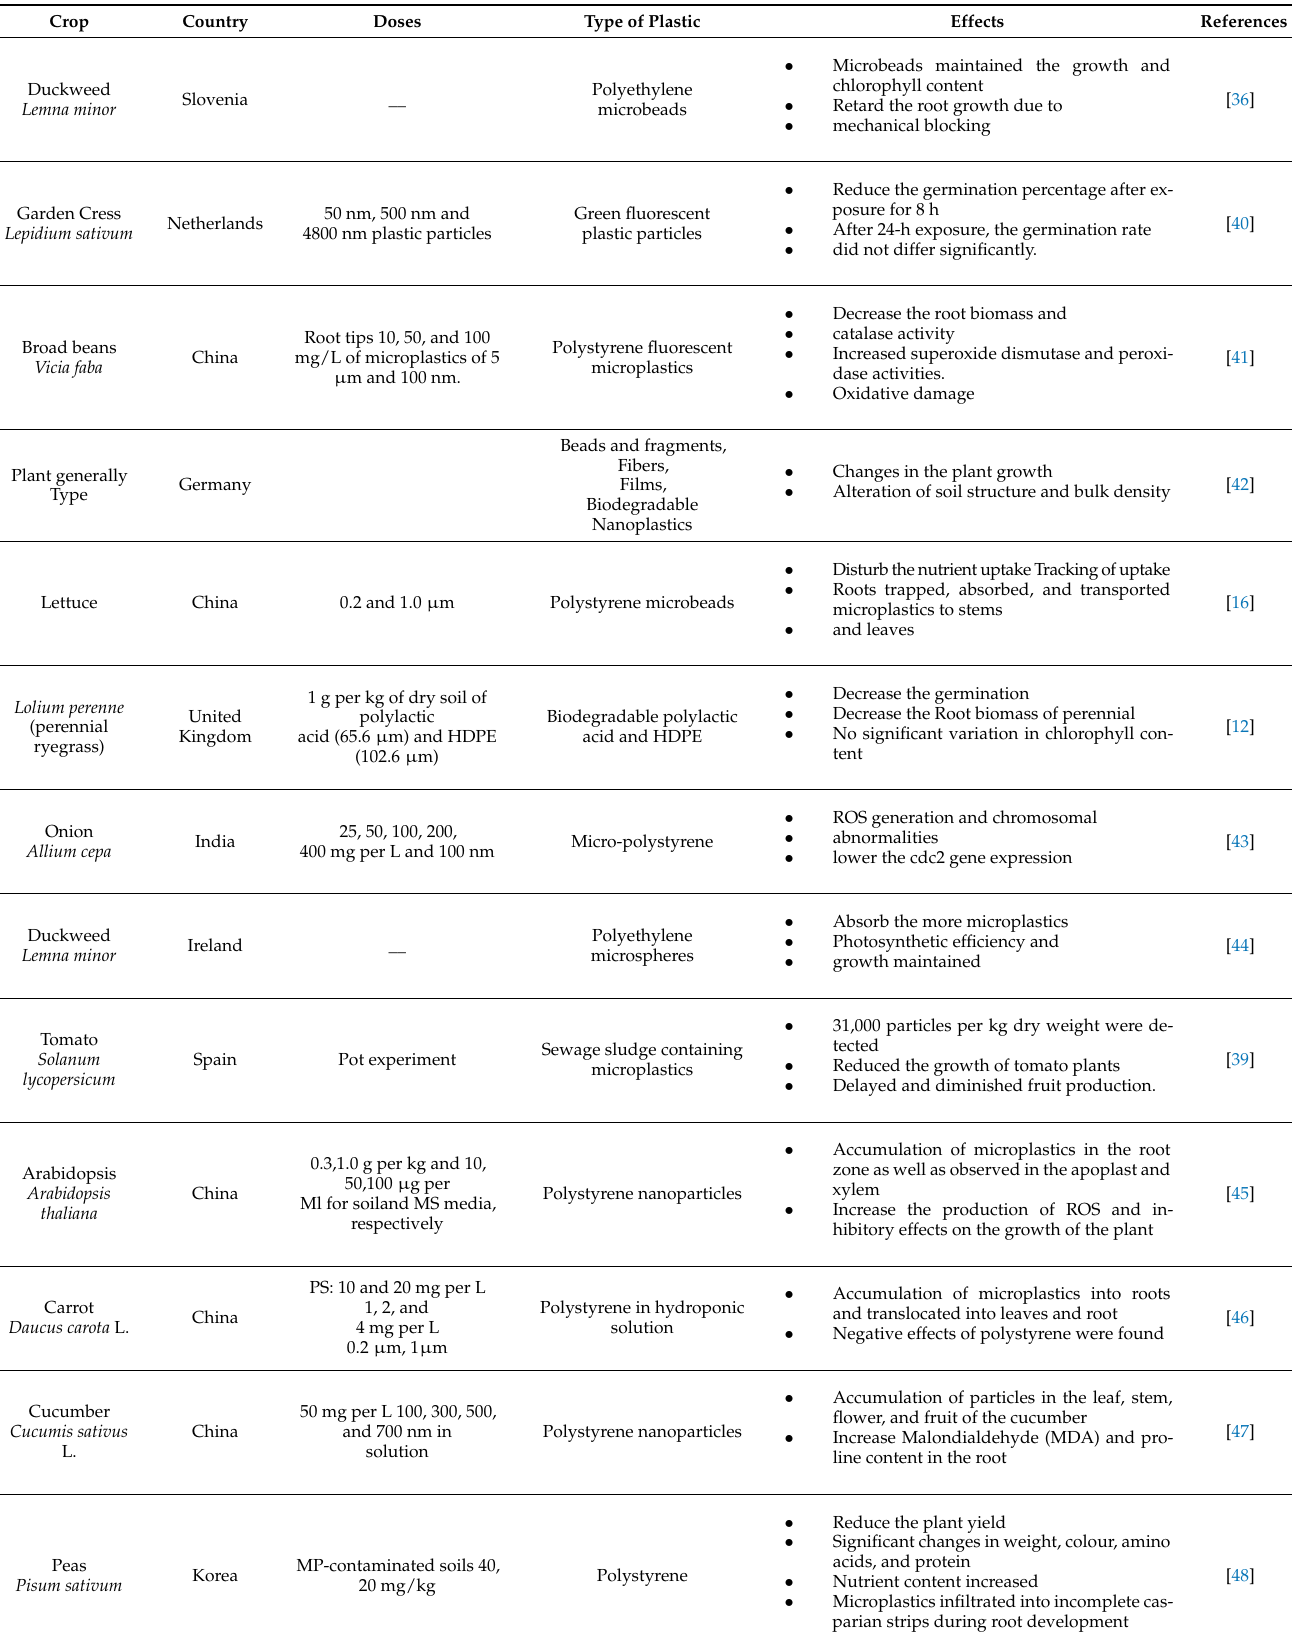
Table 1. Eco-toxicity of microplastics and their derivatives on different horticultural